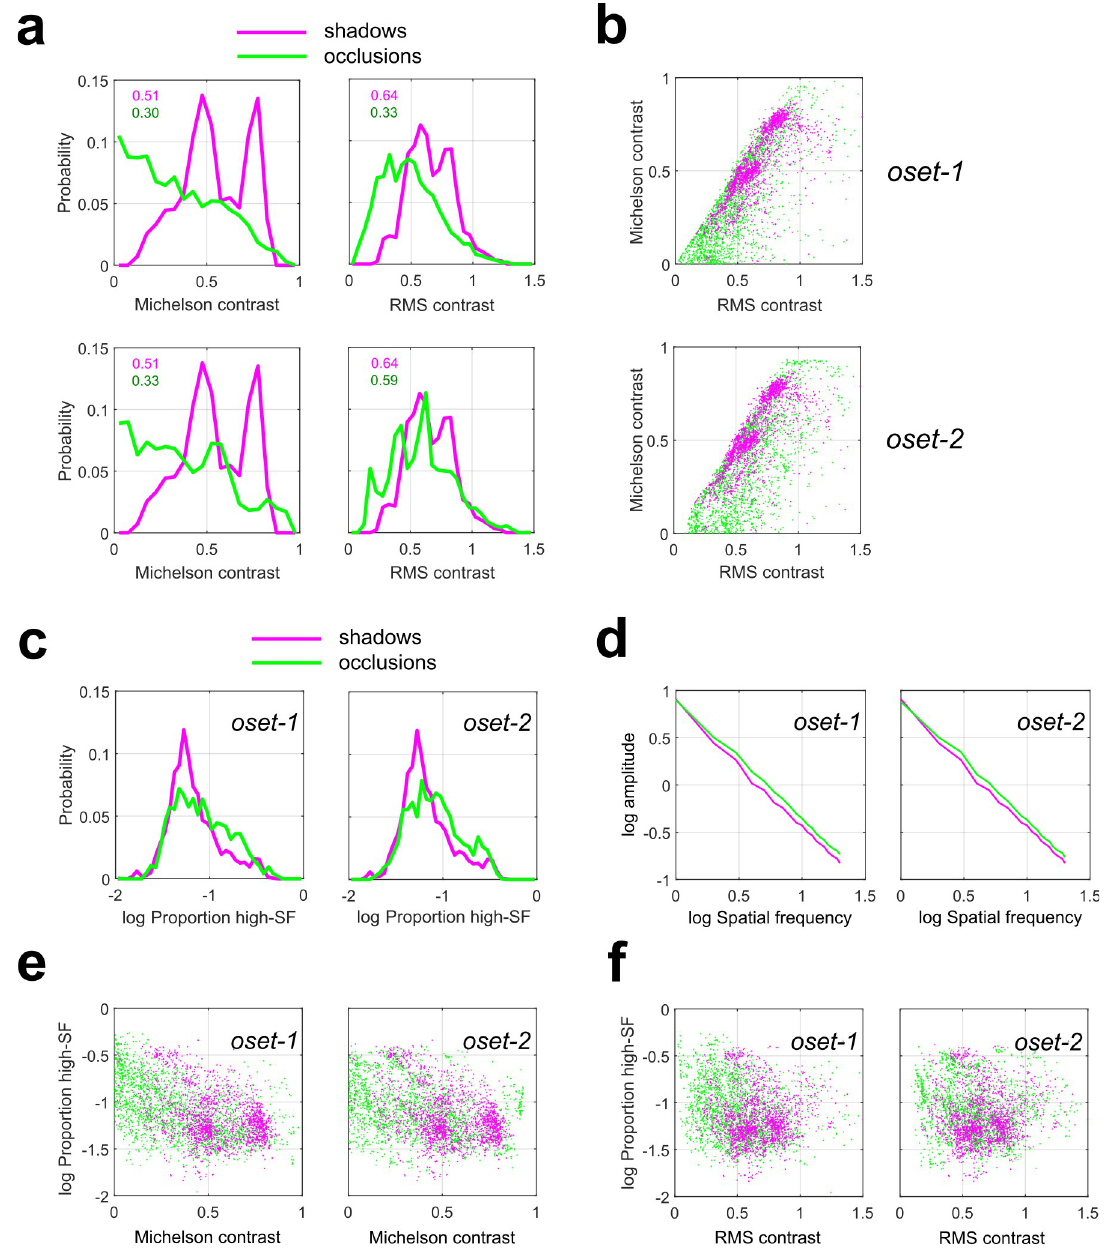
Fig 2. Contrast statistics measured from shadow and occlusion edges (N = 2000 of each category). Green curves/symbols indicate occlusions, Magenta curves/symbols indicate shadows. ( a ) Distributions of Michelson contrast ( left ) and RMS contrast ( right ) for our shadow database and two sets of occlusions ( oset-1 : top , oset-2 : bottom ). Note that for both occlusion sets, the highest and lowest contrast edges are occlusions. ( b ) Two-dimensional scatterplot of contrast measurements for shadow and occlusion edges for both sets of occlusions. ( c ) Probability distribution of stimulus power π h in the high spatial frequency ( > 10 cycles/image) range for our shadow database (magenta curves) and both occlusion sets (green curves). ( d ) Rotational average of the amplitude spectrum for shadows (magenta curves) and both occlusion sets (green curves). ( e ) Scatterplots of π h and Michelson contrast c M for shadows (magenta . symbols) and both occlusion sets (green symbols). ( f ) Same as (c) but for RMS contrast c RMS